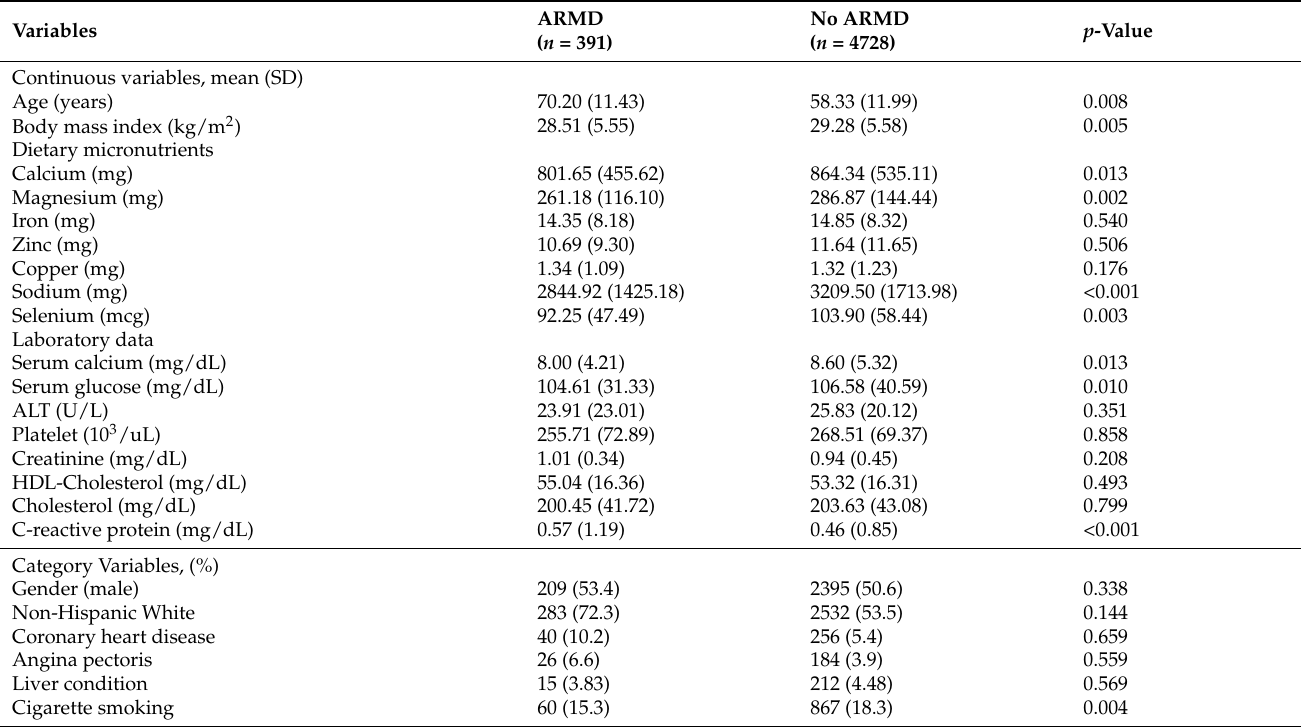
Table 1. Characteristics of the study population.